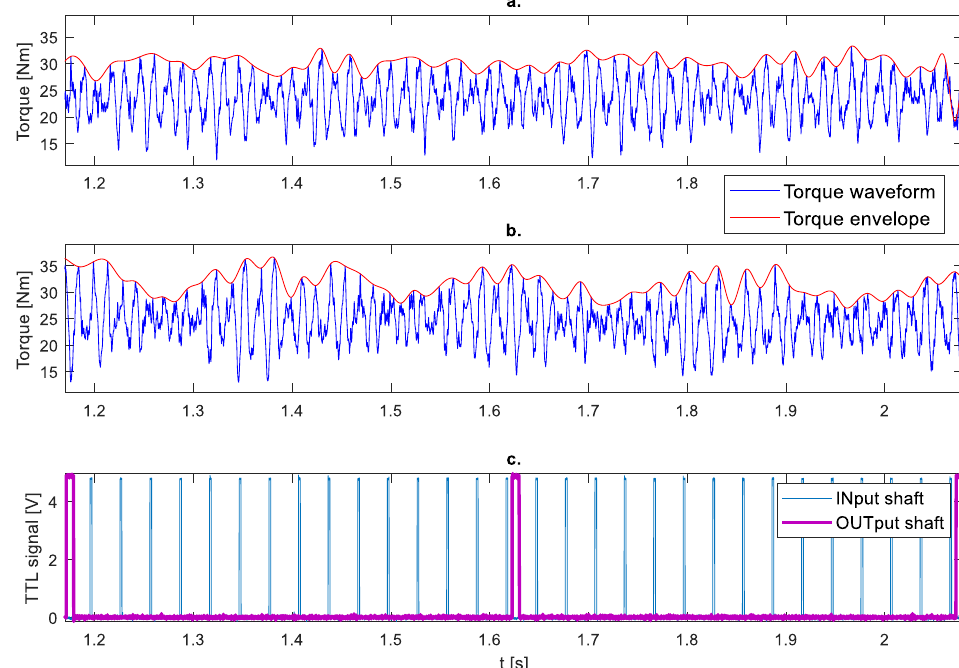
Figure 7. Torque waveform during two revolutions of the output shaft at a speed of 2000 rpm and a load of 30 Nm: ( a ) Fault-free, ( b ) Faulty, ( c ) Tachometers signals.